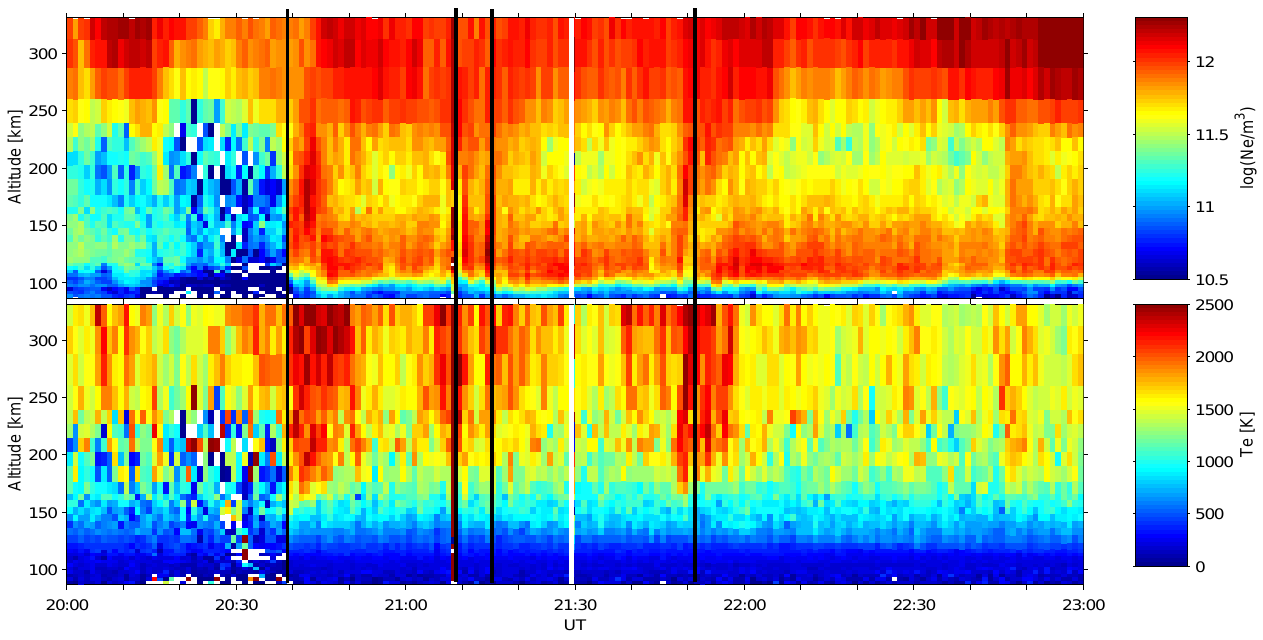
Fig. 8. One-min resolution EISCAT data of electron density and electron temperature. Substorm onset and intensifications are seen at 20:39, 21:08, 21:13, and 21:48 UT. The onset and intensification times, as determined from ground-based magnetic field data, are marked with the vertical solid lines.